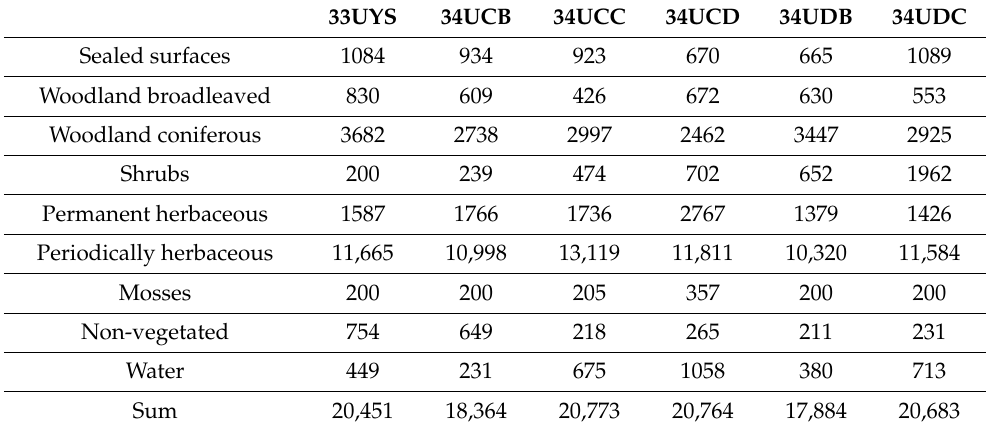
Table 3. Total number of samples per land cover class for all six Sentinel-2